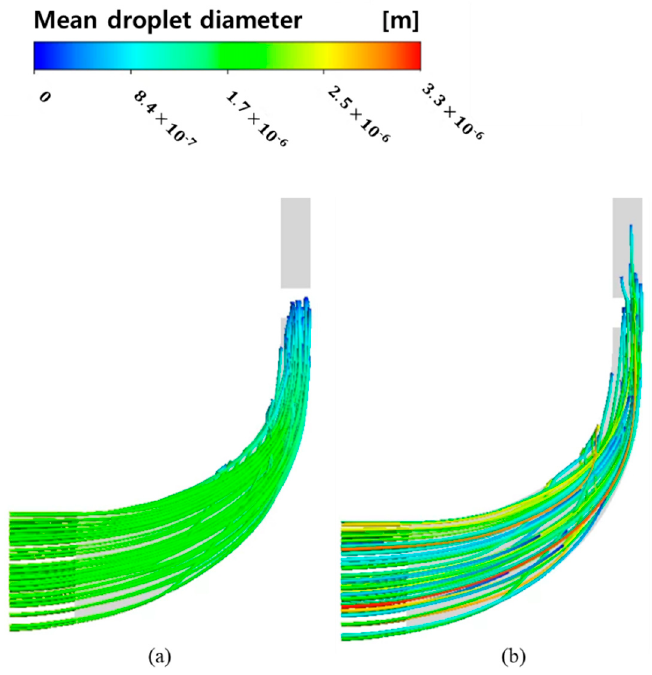
Figure 6. Droplet trajectories on the meridional plane under different injection conditions; ( a ) homogeneous injection and ( b ) heterogeneous injection.